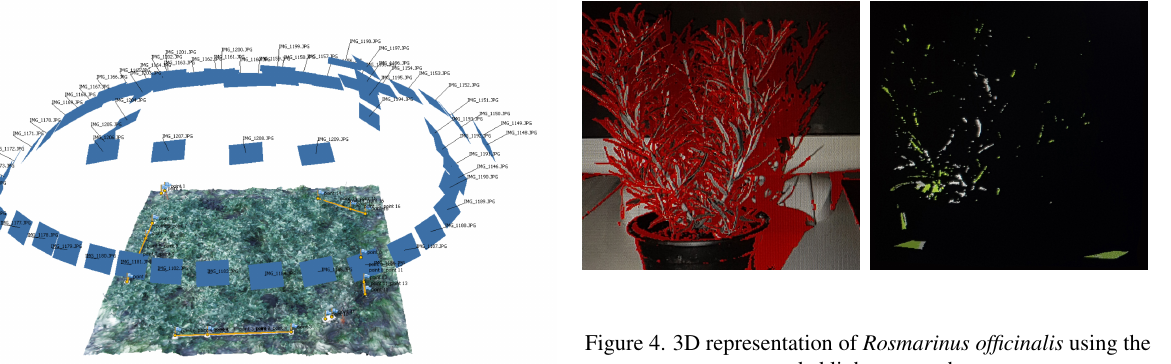
Figure 4. 3D representation of Rosmarinus officinalis using the coded light